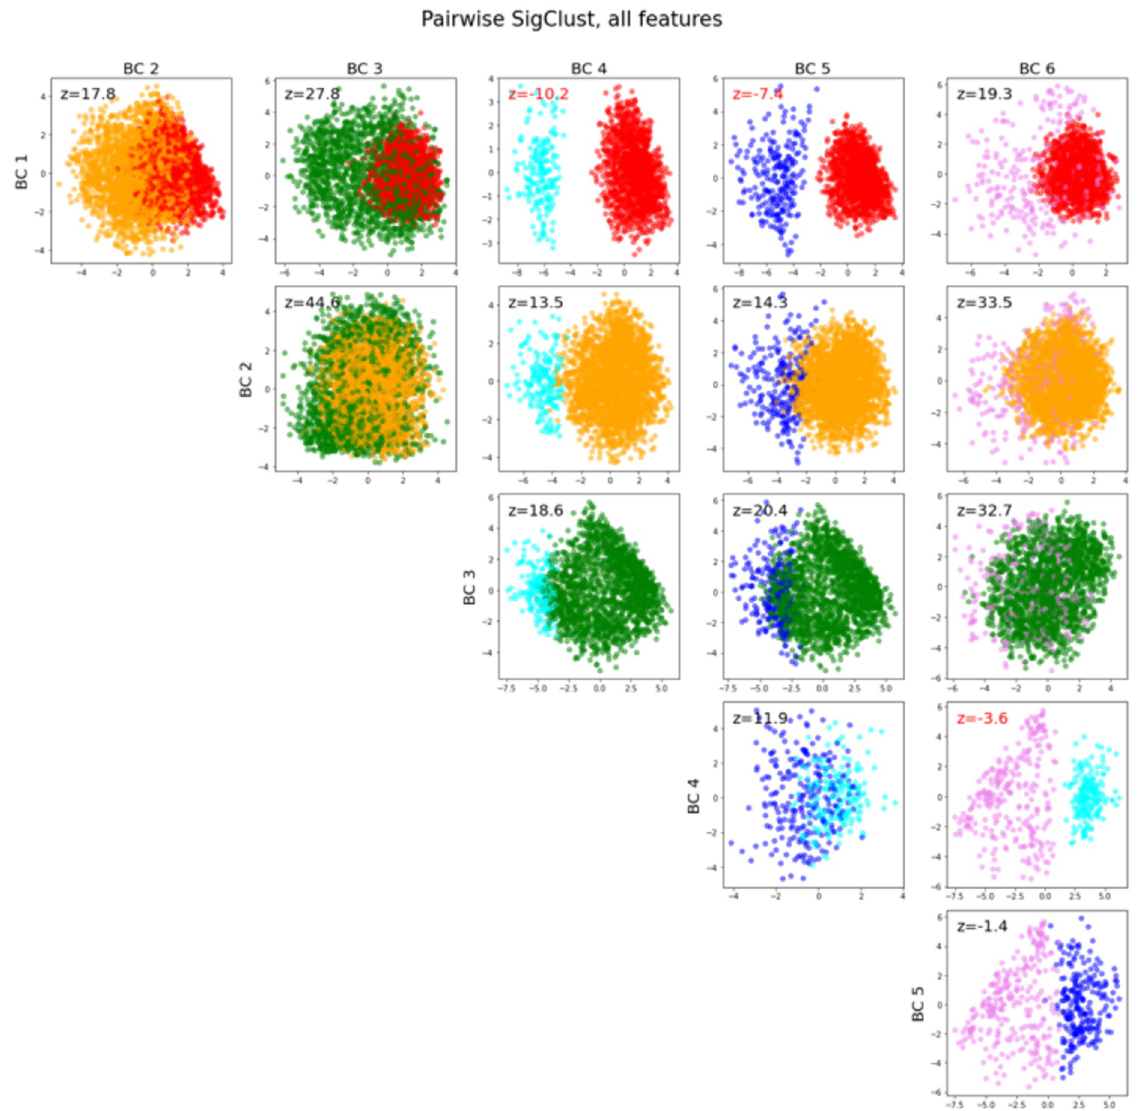
Fig 5. Pairwise SigClust among each pair of biclusters. Each pair of biclusters is plotted in a two-dimensional scatterplot: the horizontal axis of each scatterplot is the mean-difference direction (the vector between the centers of the biclusters) and the vertical axis is the orthogonal principal component to the mean-difference direction. The SigClust z-score for the pair of biclusters is printed on the plot in black, and in red if it is below -2 (which would demonstrate statistical significance in the absence of multiple